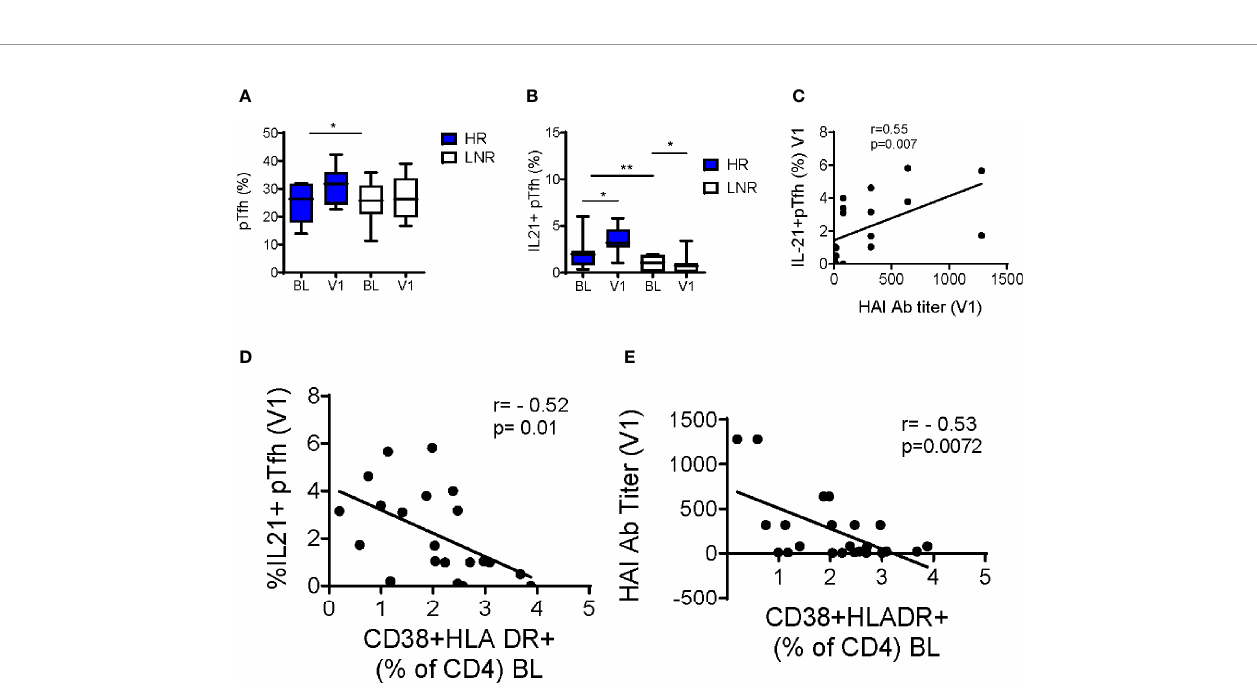
FIGURE 7 | Increase in pTfh Frequency and Function Post-Vaccination in pH1N1 Responders. (A) Frequencies of CD4+CD45RO+CXCR5+ peripheral T follicular helper cells (pTfh) without stimulation and (B) IL-21+ pTfh after 12-hour stimulation with H1N1 from responders (n=14) and non-responders (n=14) at baseline (BL) and post vaccination (visit 1, V1). Pearson correlations between (C) IL-21+pTfh at V1 following H1N1 stimulation with HAI titers at V1 (D) IL-21+pTfh at V1 following H1N1 stimulation with baseline CD4 Immune activation (E) HAI titers at V1 with baseline CD4 Immune activation. P-values were calculated with Student ’ s t-test or Mann-Whitney test as appropriate. Box plots include median with 25th and 75th percentile borders, and error bars represent 10th and 90th percentiles. Stars indicate the level of signi fi cance: *p < 0.05, **p <